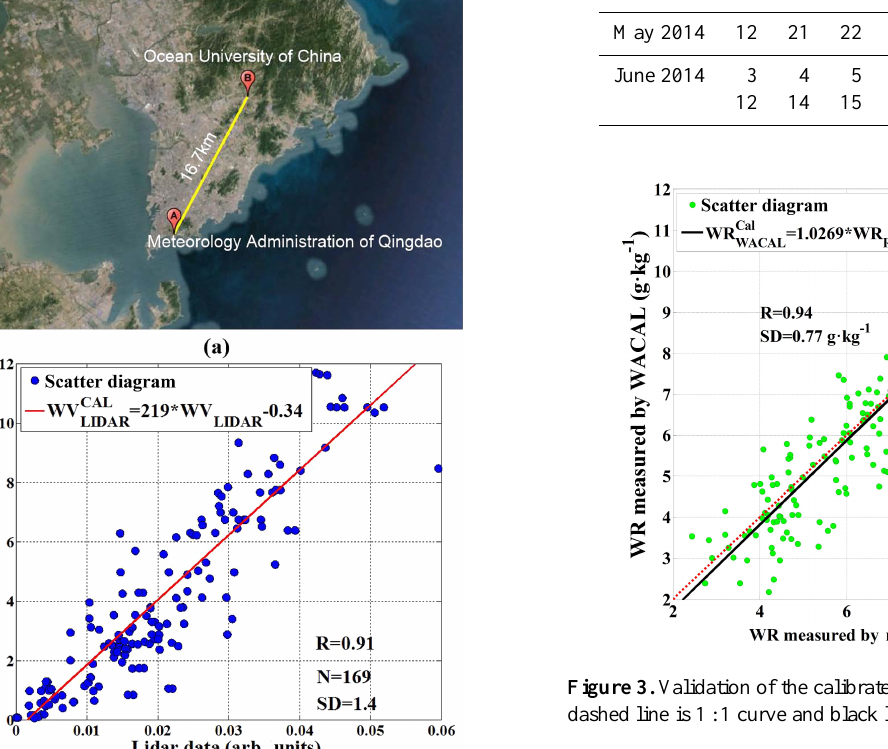
Table 4. Period of time of the simultaneous observations.